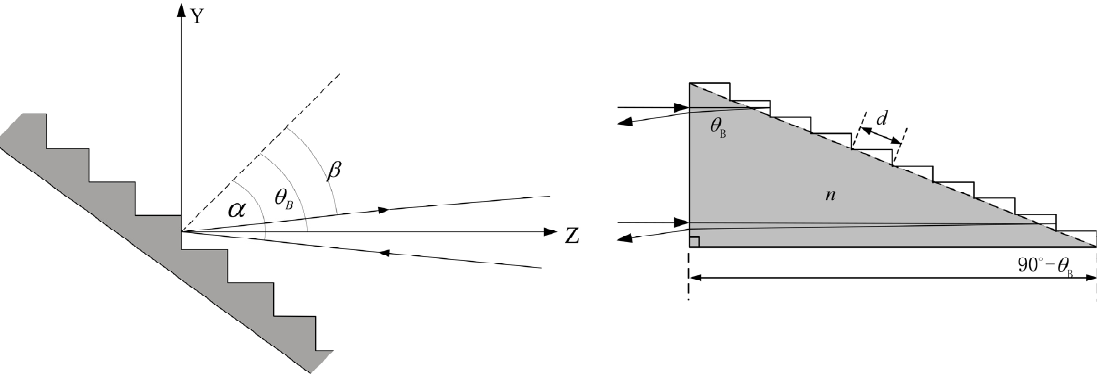
Figure 3. Conventional reflective grating and immersion grating.